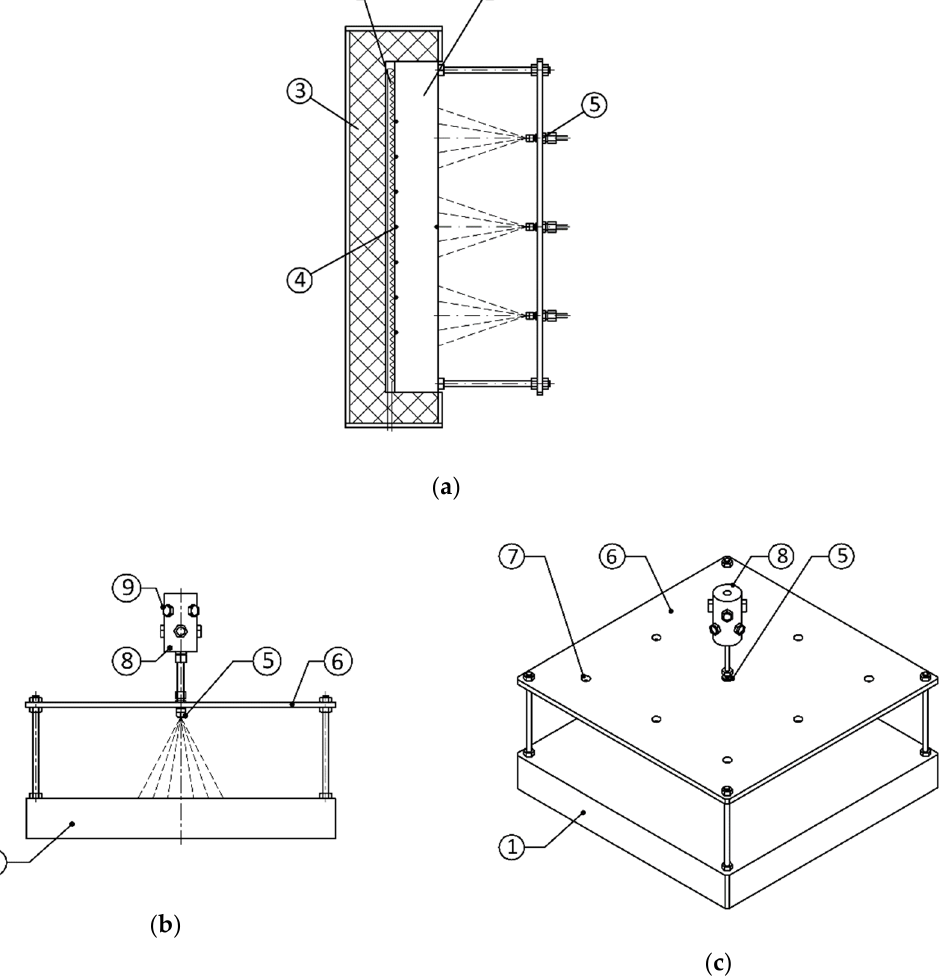
Figure 5. Spray cooling stand for thick-walled, electrically heated plate: ( a ) cross-section of the stand; ( b ) cross-section of the water-cooled plate; ( c ) an isometric view showing the holes in the top plate where the water spray nozzles are located: 1 —thick plate; 2 —electrical silicone heater; 3 —thermal insulation; 4 —jacket thermocouples; 5 —water spray nozzles; 6 —upper plate in which the nozzles are mounted; 7 —hole for mounting the nozzle; 8 —cooling water distributor; 9 —connection spigot.